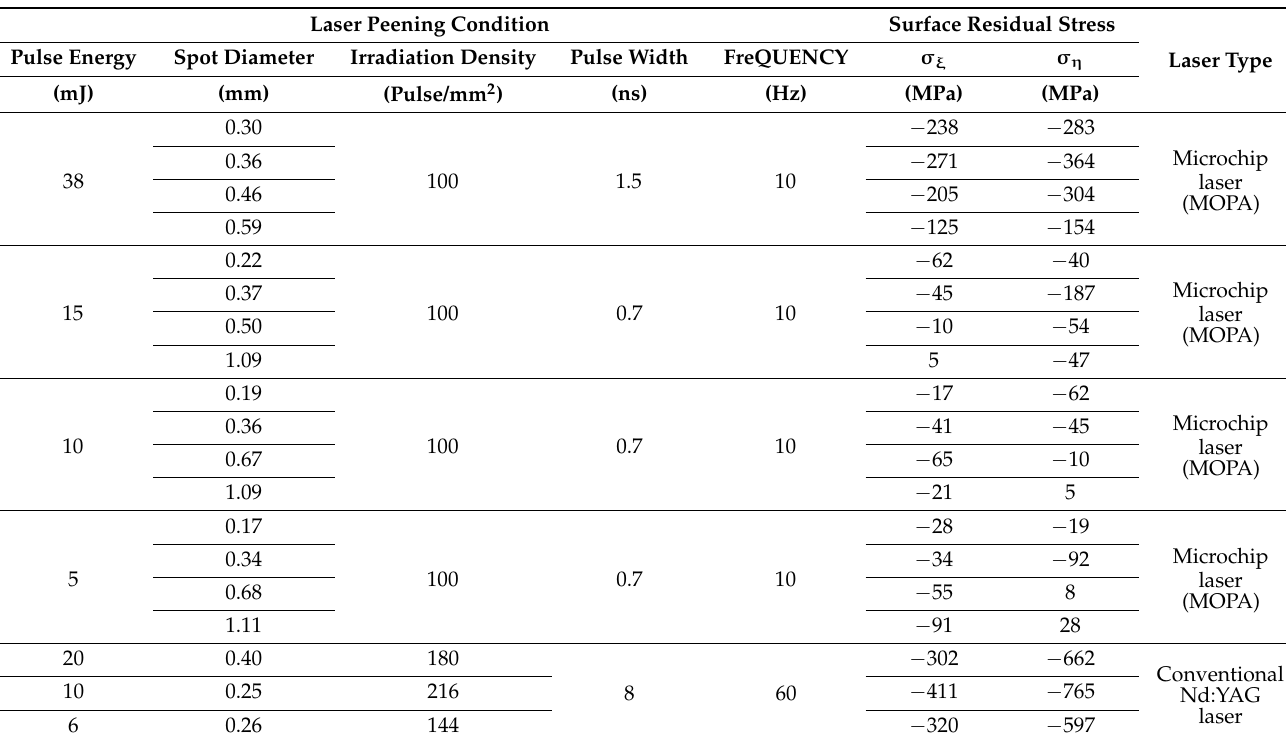
Table 2. Laser peening conditions and results of residual stress